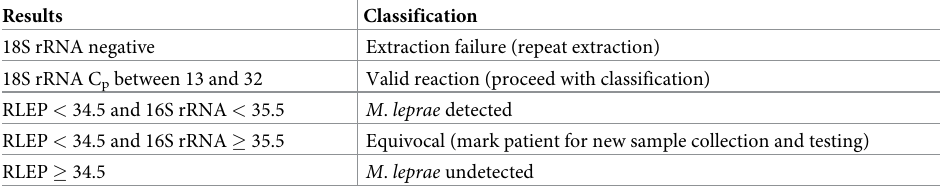
Table 3. Decision algorithm for classification of samples based on the data obtained with the new multiplex qPCR.